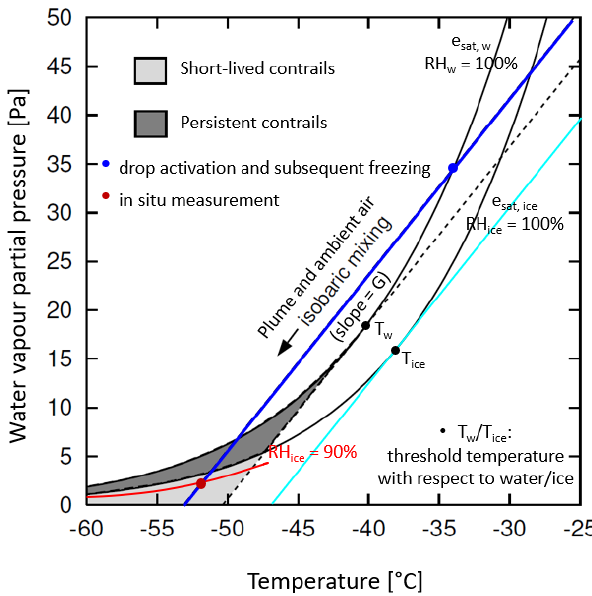
Figure 1. Water vapour saturation partial pressure with respect to liquid water ( e sat , w ) and ice ( e sat , ice ) as a function of tempera- ture. The blue line represents the isobaric mixing of the aircraft exhaust plume with the surrounding ambient air at a gradient of G along the black arrow. During the isobaric mixing, liquid drops form when surpassing water saturation; the drops freeze subsequently at ∼ 235K. The red dot represents an in situ-measured cloud sample that marks the ending point of the cloud sample’s mixing. T w is the threshold temperature for contrails to form. This occurs when the isobaric mixing line (the dashed line) just touches the water satura- tion curve. In this case, contrails persist in ice-supersaturated envi- ronments and live only shortly in ice subsaturation, as indicated by the dark- and light-grey areas, respectively. The cyan line shows a situation where the aircraft exhaust air parcel just reaches ice sat- uration so that contrail ice particles might form directly from the gas phase heterogeneously or homogeneously at the corresponding ice supersaturation. The red curve at RH ice = 90% represents the proposed lower RH ice threshold of persistent contrails in this work (Sect.